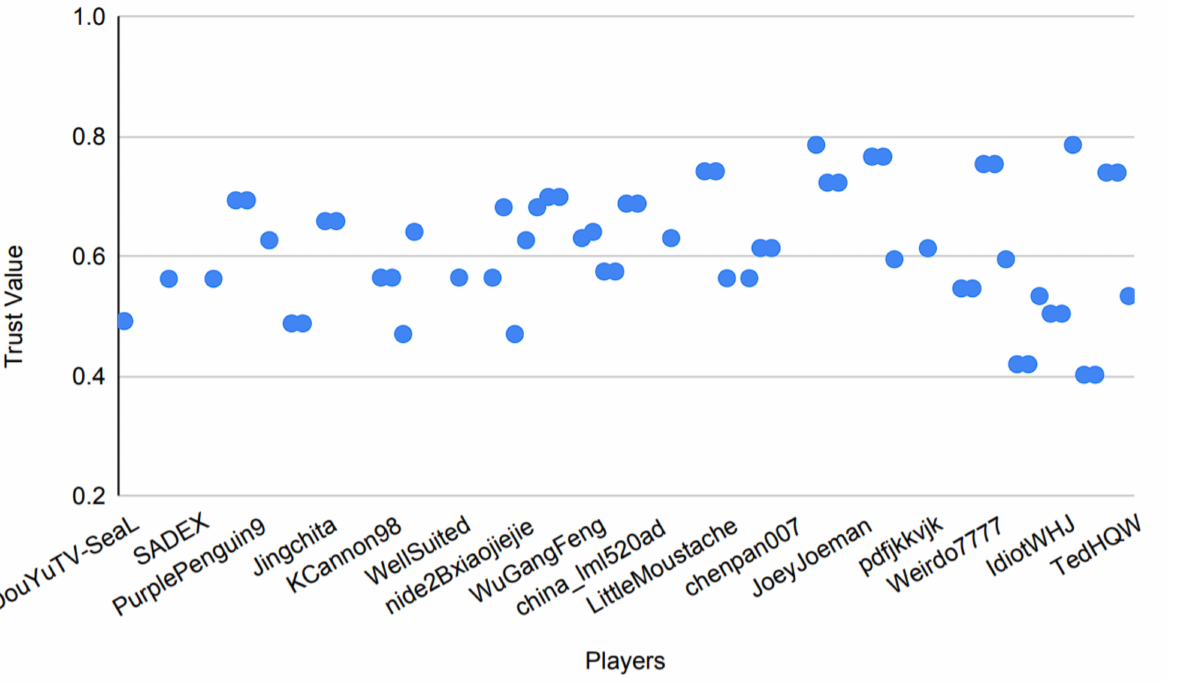
Figure 20. Maximum trust values of top ~20% of players achieved at the end of the match from the